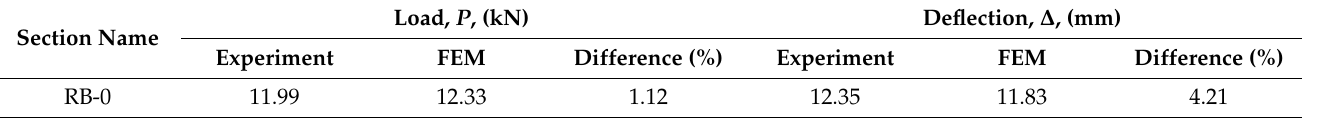
Table 3. Validation of the GFRP beam bending results.